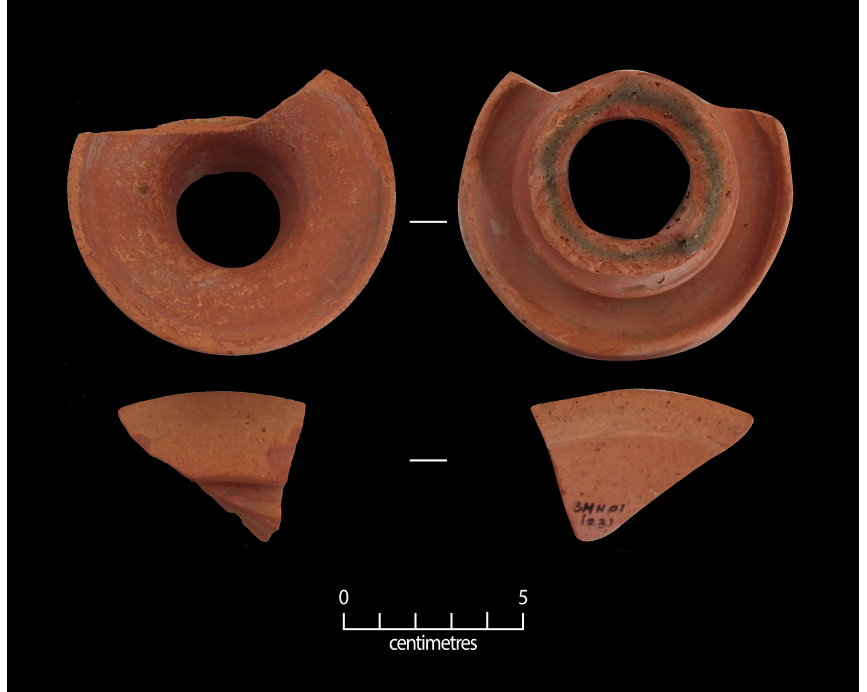
Figure 4: External and internal surfaces of a Class 1 variant 2 necked vessel with everted